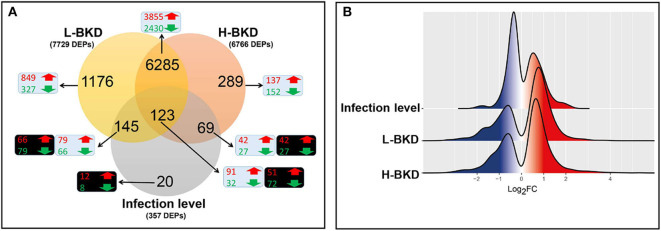
Microarray results of Atlantic salmon head kidney in response to R. salmoninarum infection. Fish with no (Control), lower (L-BKD) or higher (H-BKD) level of R. salmoninarum infection at 13 dpi were used for microarray analyses (n = 5). Fish in the L-BKD and H-BKD groups were infected with the same dose of R. salmoninarum, but they showed different levels of infection at 13 dpi, as determined by RNA-based Taq-Man assays. H-BKD: H-BKD vs. Control. L-BKD: L-BKD vs. Control. Infection level: H-BKD vs. L-BKD. (A) Overview of microarray results. Differentially expressed probes (DEPs) identified by ANOVA (p < 0.01). The number of up-regulated (red) and down-regulated (green) probes in BKD- (L-BKD or H-BKD vs. Control) and infection level (H-BKD vs. L-BKD)-responsive lists are shown in blue and black boxes, respectively. (B) Histogram of the frequency density of log2-transformed fold-changes (FC) for the DEPs of the different comparisons. Red and blue colours indicate up-regulation and down-regulation, respectively.